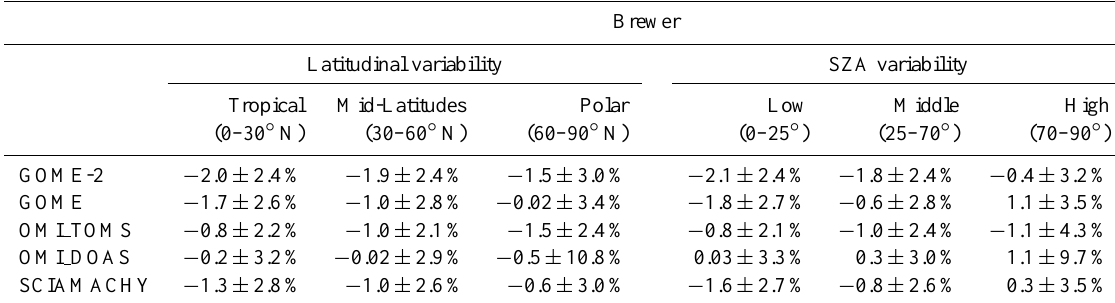
Table 2. The average differences between satellite and ground-based instruments for the five datasets shown in this paper. The mean and standard deviation for the latitudinal and the SZA variability are given for the Brewer instruments for low, middle and high latitudes and angles respectively.